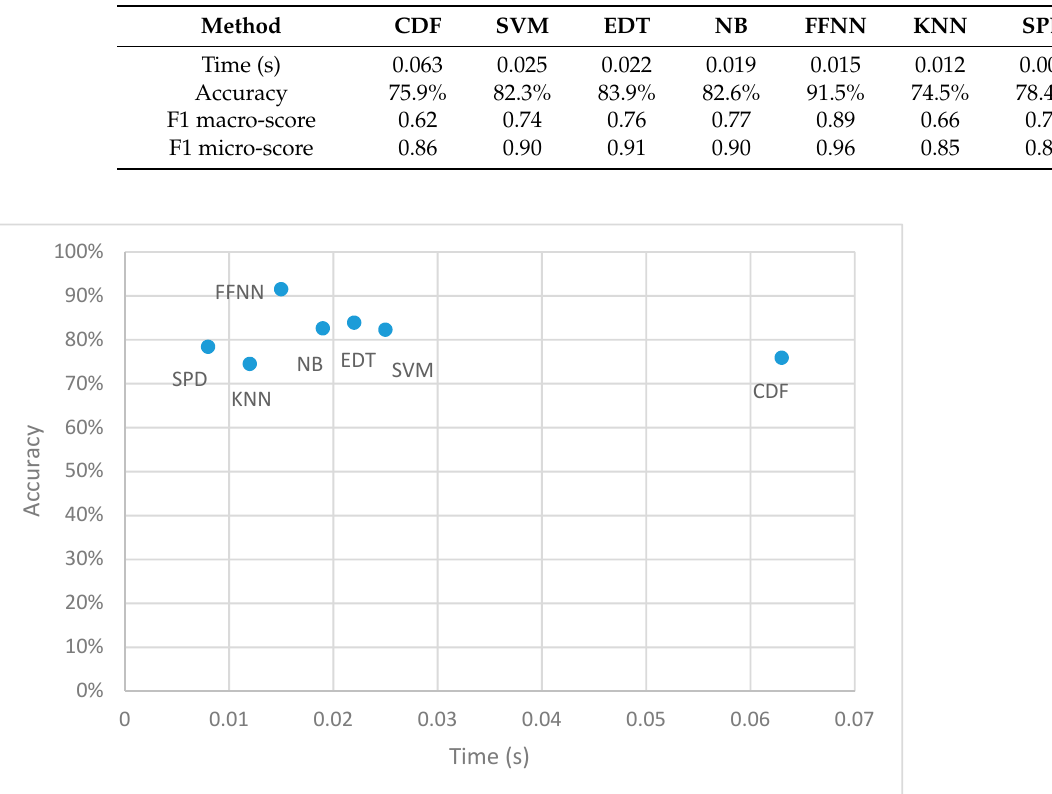
Figure 10. Classification speed vs. accuracy comparison.